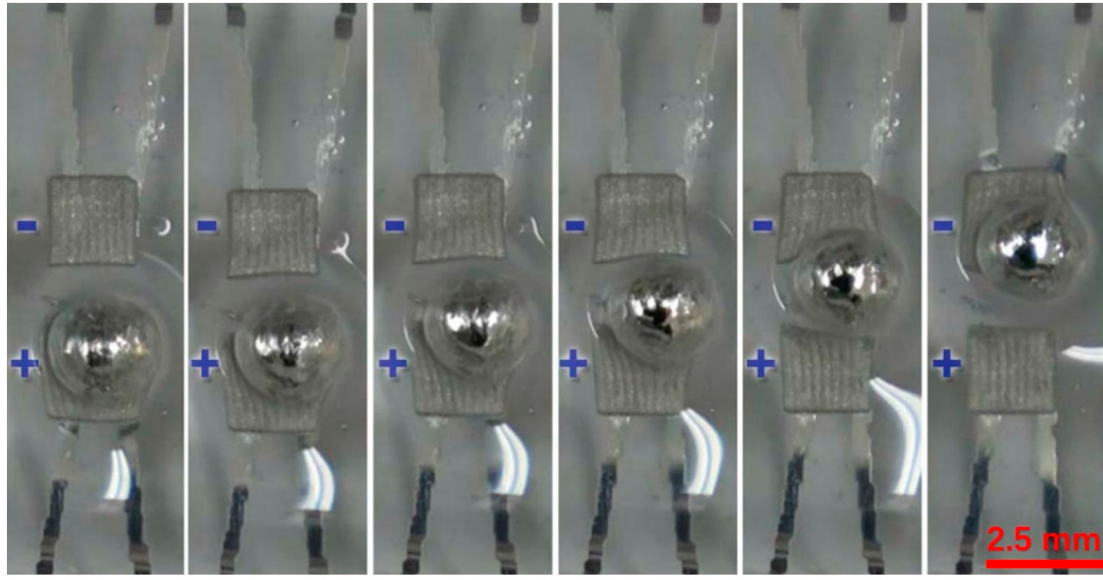
Figure 4. Details of large droplet moving from one electrode to another. Only two electrodes are included. “+” represents +1000 V, and “ − ” represents − 1000 V.